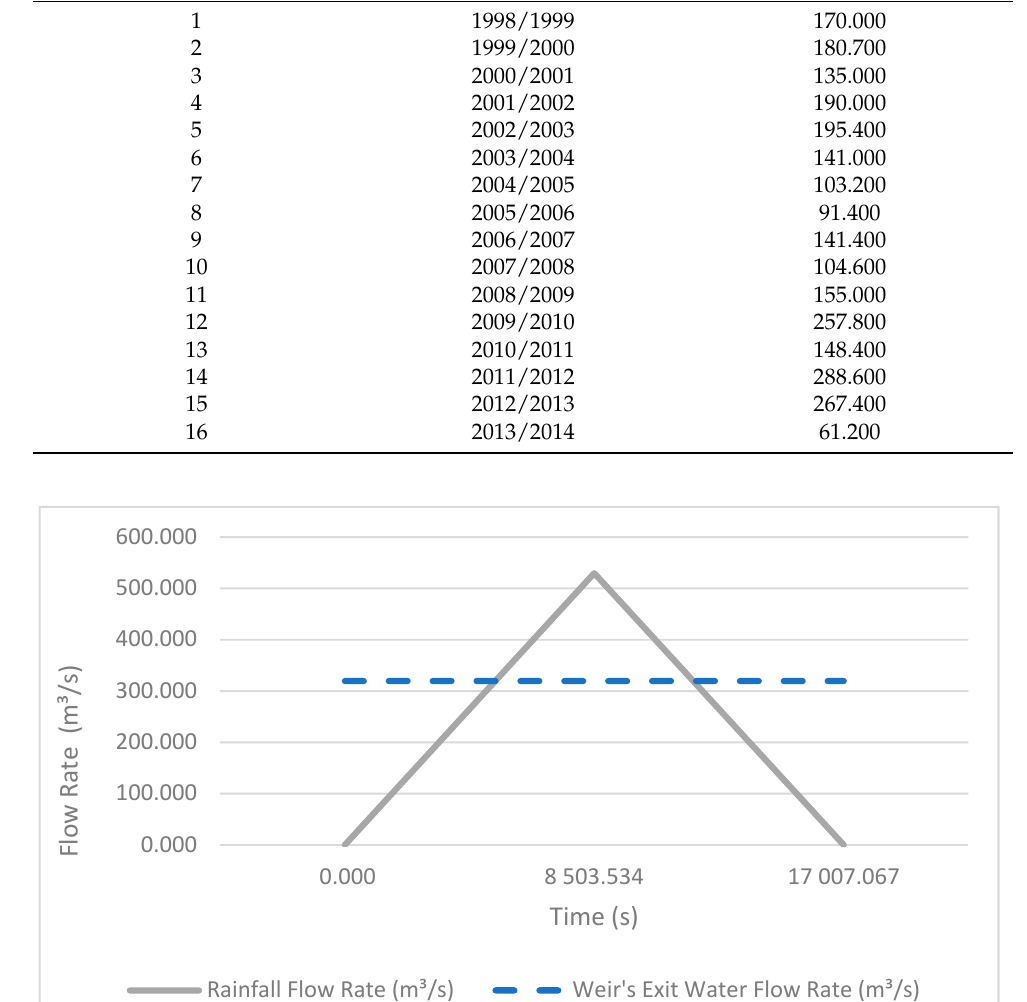
Figure A1. Ternary phase diagram.